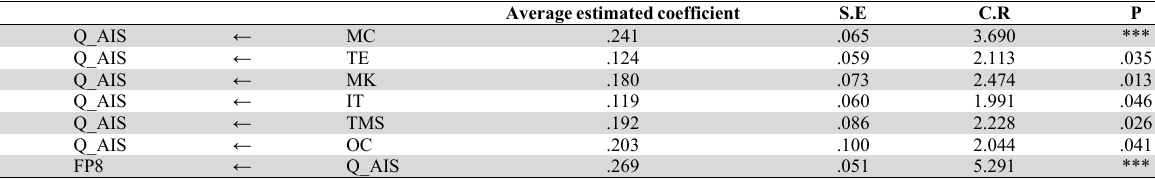
Model test results